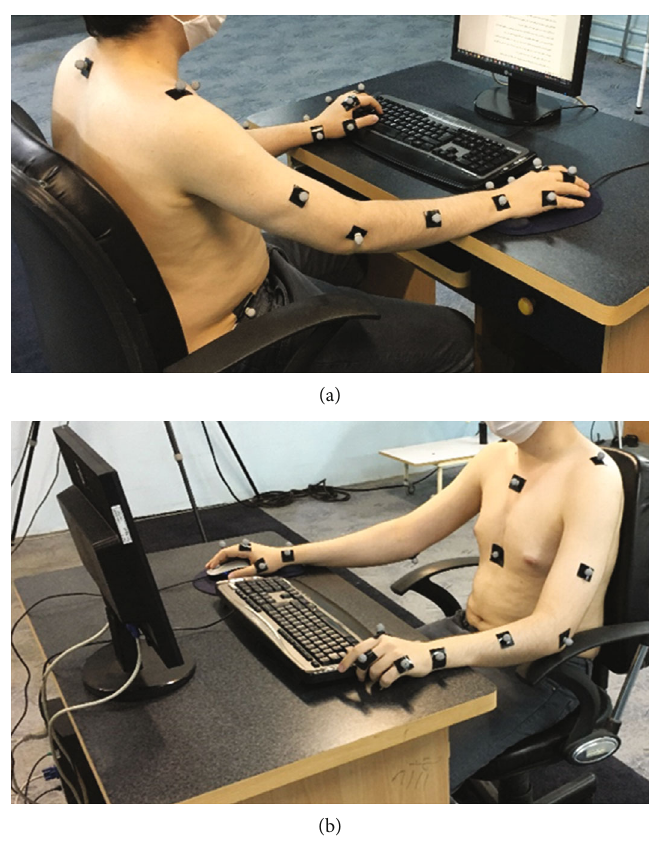
Figure 3: Experimental setup in the motion capture laboratory. (a) Right and (b) left